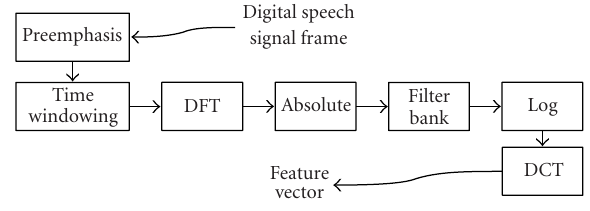
Figure 2: MFCC signal processing